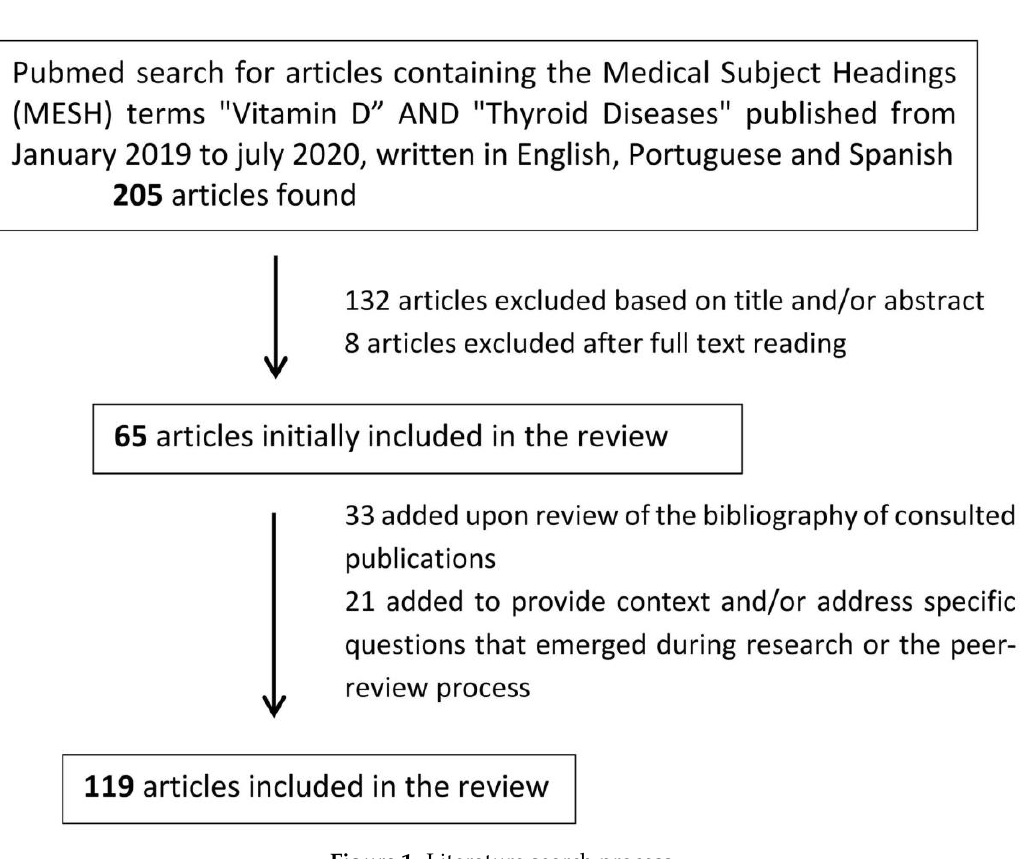
Figure 1. Literature search process.